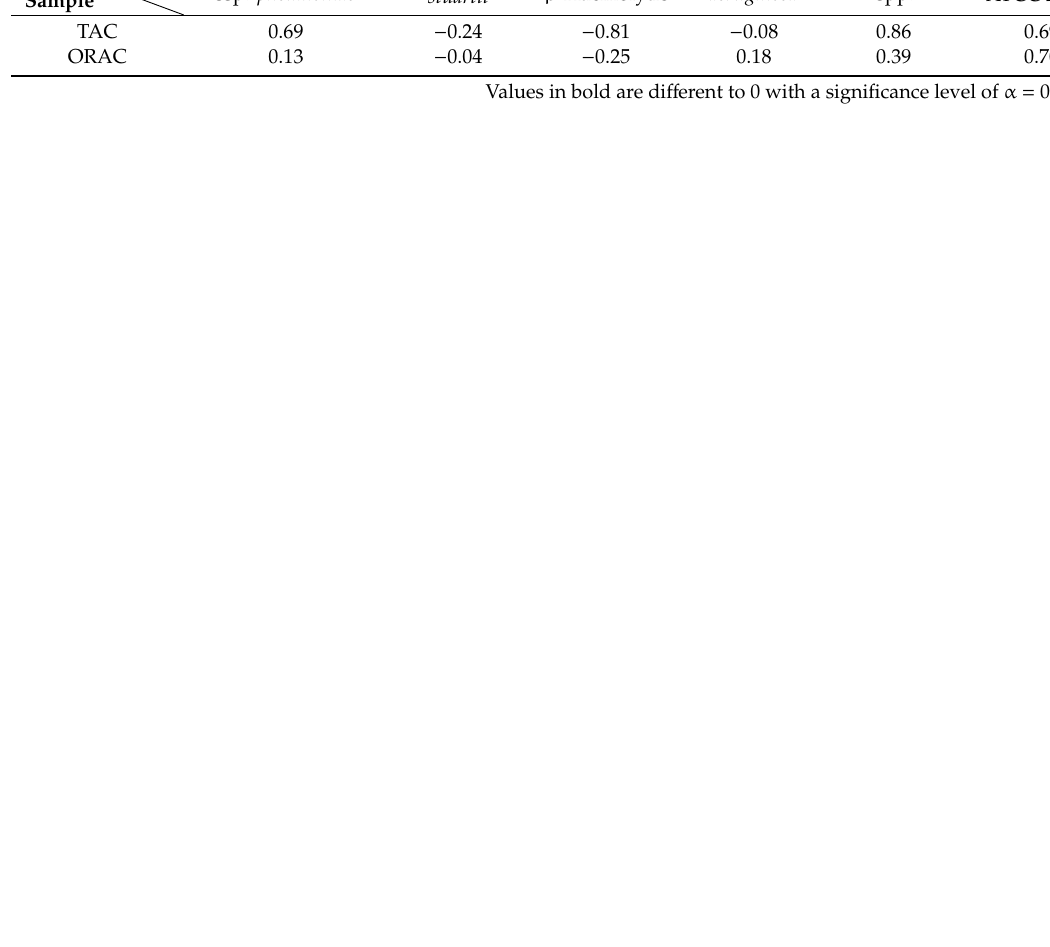
Values in bold are di ff erent to 0 with a significance level of α =